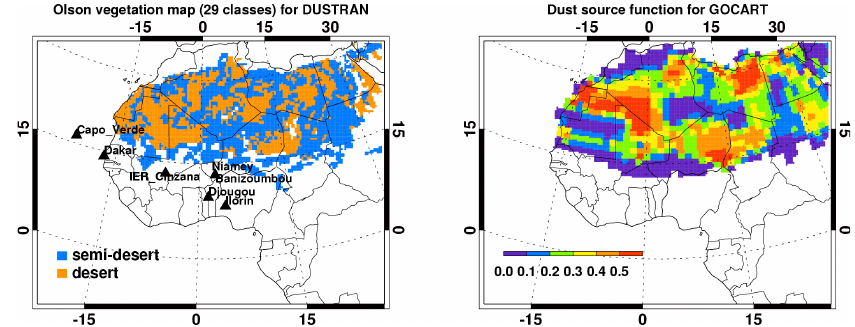
Fig. 1. Spatial distribution of desert and semi-desert masks determined by the Olson World Ecosystem database (29 classes) for the DUS- TRAN scheme and the dust source function (Ginoux et al., 2001) for the GOCART scheme over North Africa. The black triangles represent Figure 1 Spatial distribution of desert and semi-desert masks determined by the Olson 7 the locations of the six AERONET sites. The Niamey airport, 60km northwest from the Banizoumbou site, is also shown with the same triangle as World Ecosystem database (29 classes) for the DUSTRAN scheme and the dust source 8 function [Ginoux et al., 2001] for the GOCART scheme over North Africa. The black 9 triangles represent the locations of the six AERONET sites. The Niamey airport, 60 km 10 northwest from the Banizoumbou site, is also shown with the same triangle as 11 Banizoumbou. 12